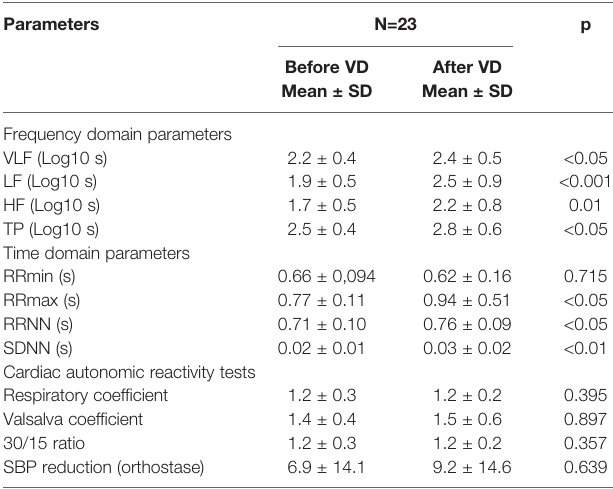
TABLE 3 | CAN parameters before and after vitamin D supplementation in patients with